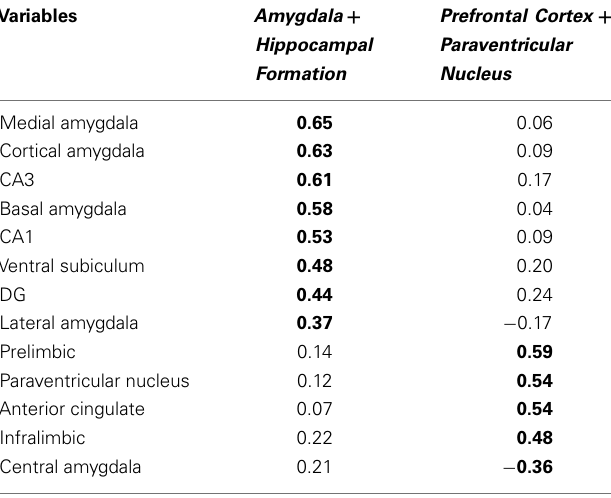
Table 1 | Component loadings for the predicted solution in